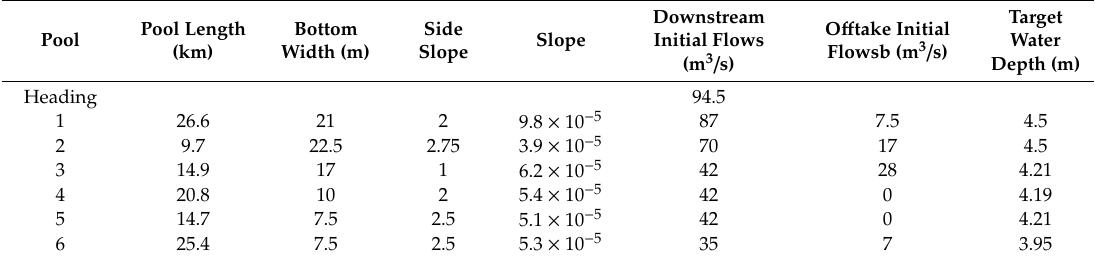
Table 1. Basic parameters and initial flow condition of each